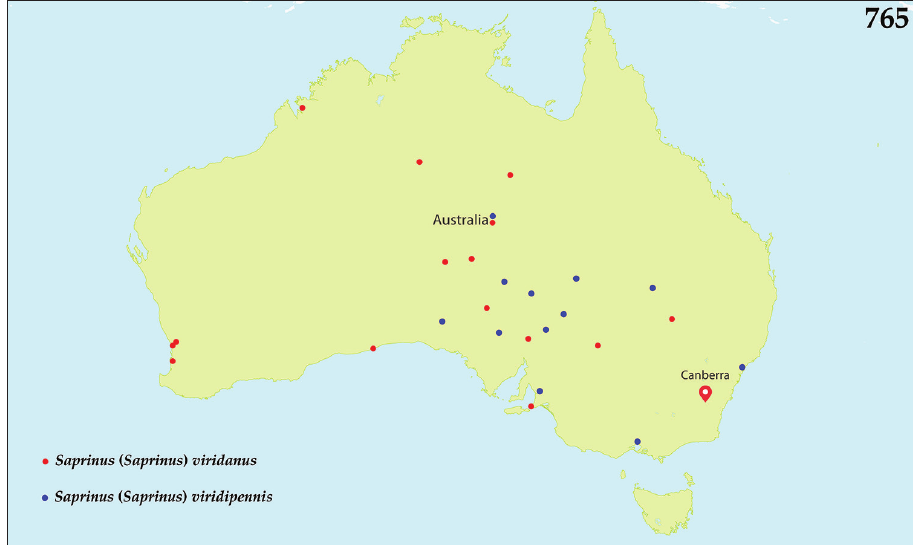
Figure 765. Distribution of Saprinus ( Saprinus ) viridanus Lewis, 1899 and Saprinus ( Saprinus ) viridipennis Lewis, 1901 in